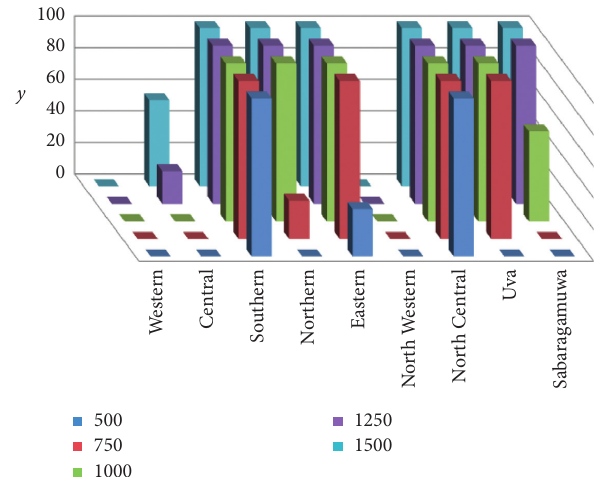
Figure 7: Variation of the optimal lockdown relaxation levels of provinces (as percentages) with the total number of ICU beds available in the country.